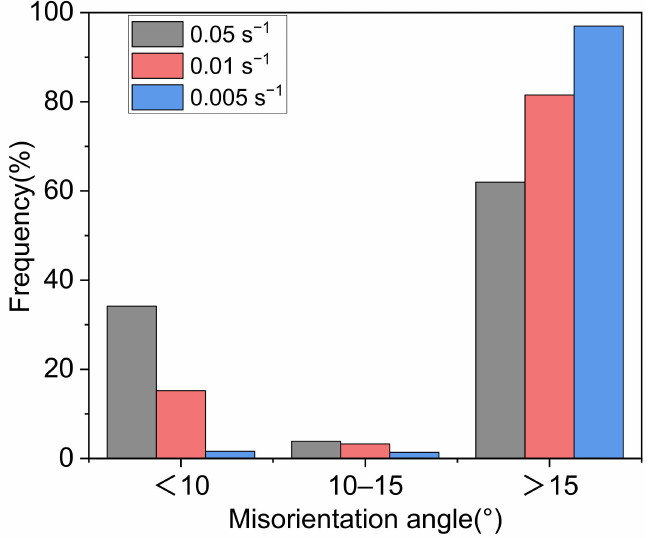
Figure 15. The changes in the fractions of different misorientation angles scopes at 1000 ◦